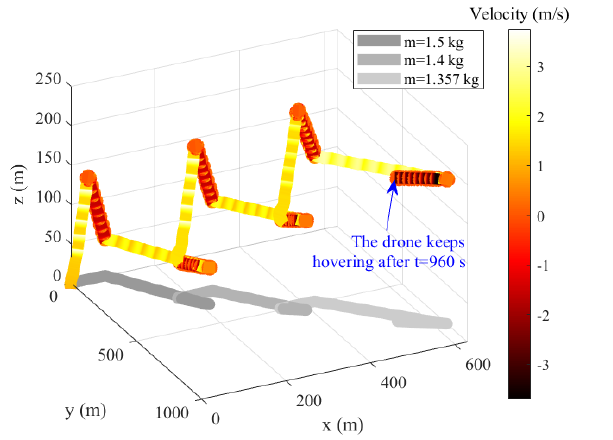
Figure 7. The representative highly maneuverable flight plan. It should be noted that the QUAV climbs and descends vertically, that is the horizontal displacement is depicted to show the motion state more intuitively, but does not really